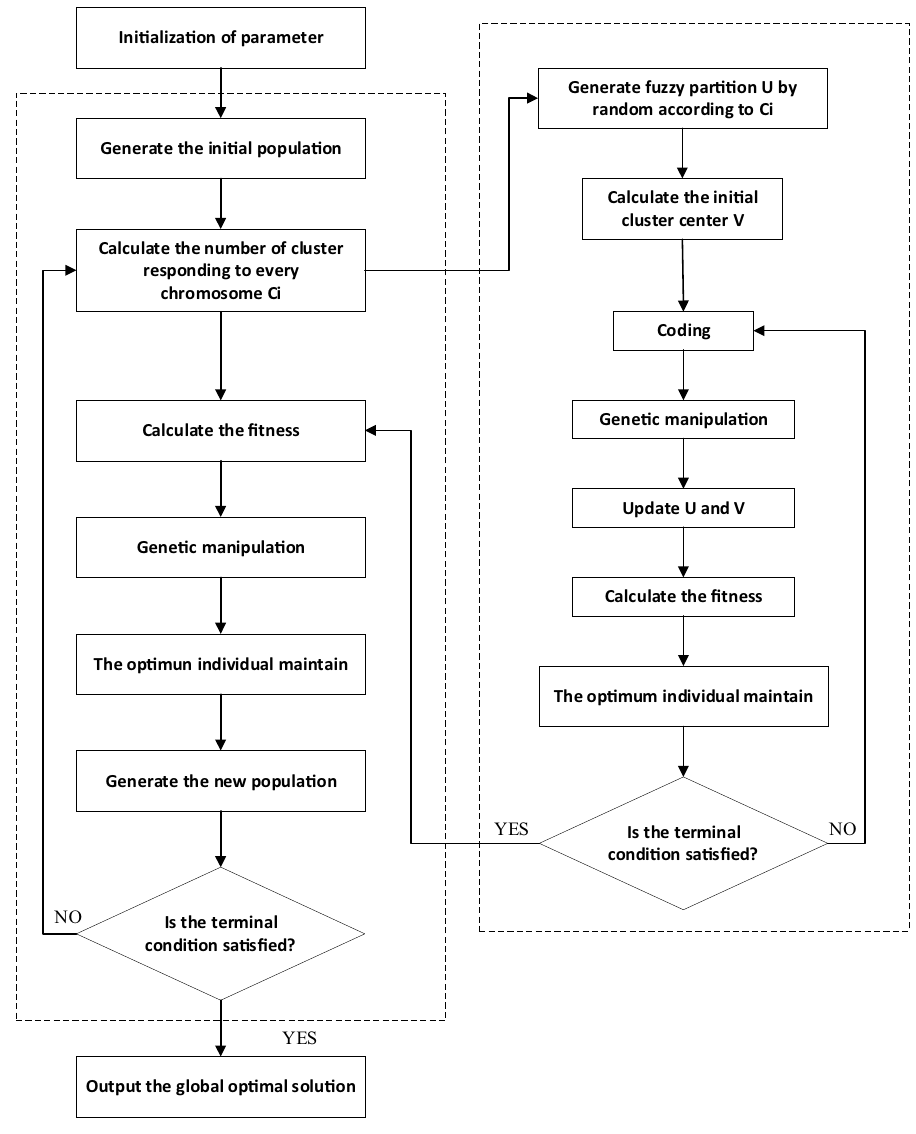
Figure 2. Schematic representation of the hybrid